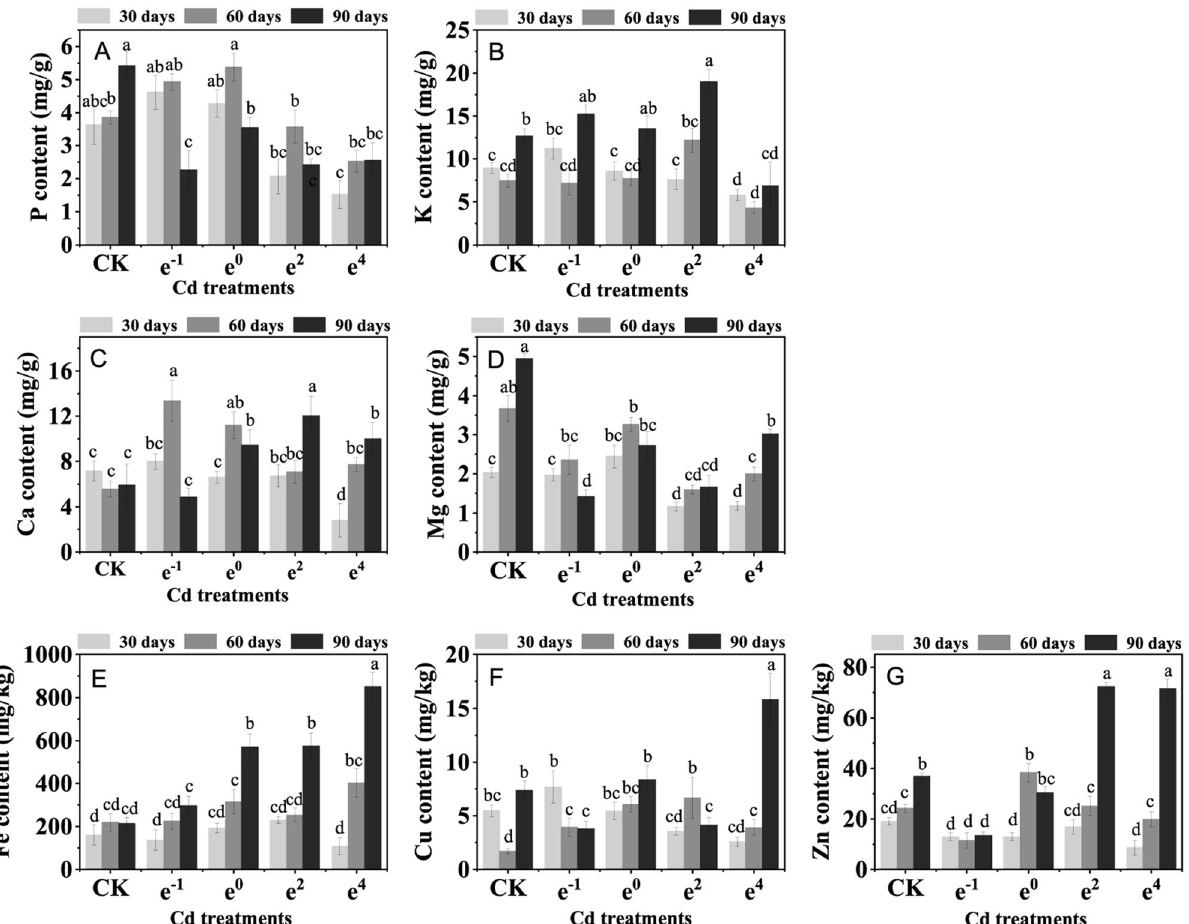
Figure 4. Changes in the P, K, Ca, Mg, Fe, Cu, and Zn content of Polygonatum sibiricum under Cd stress. A, B, C, D, E, F , and G represent P, K, Ca, Mg, Fe, Cu, and Zn, respectively. Each value represents the mean ± standard deviation of three independent experiments. Different letters above the bars represent significant differences ( p <